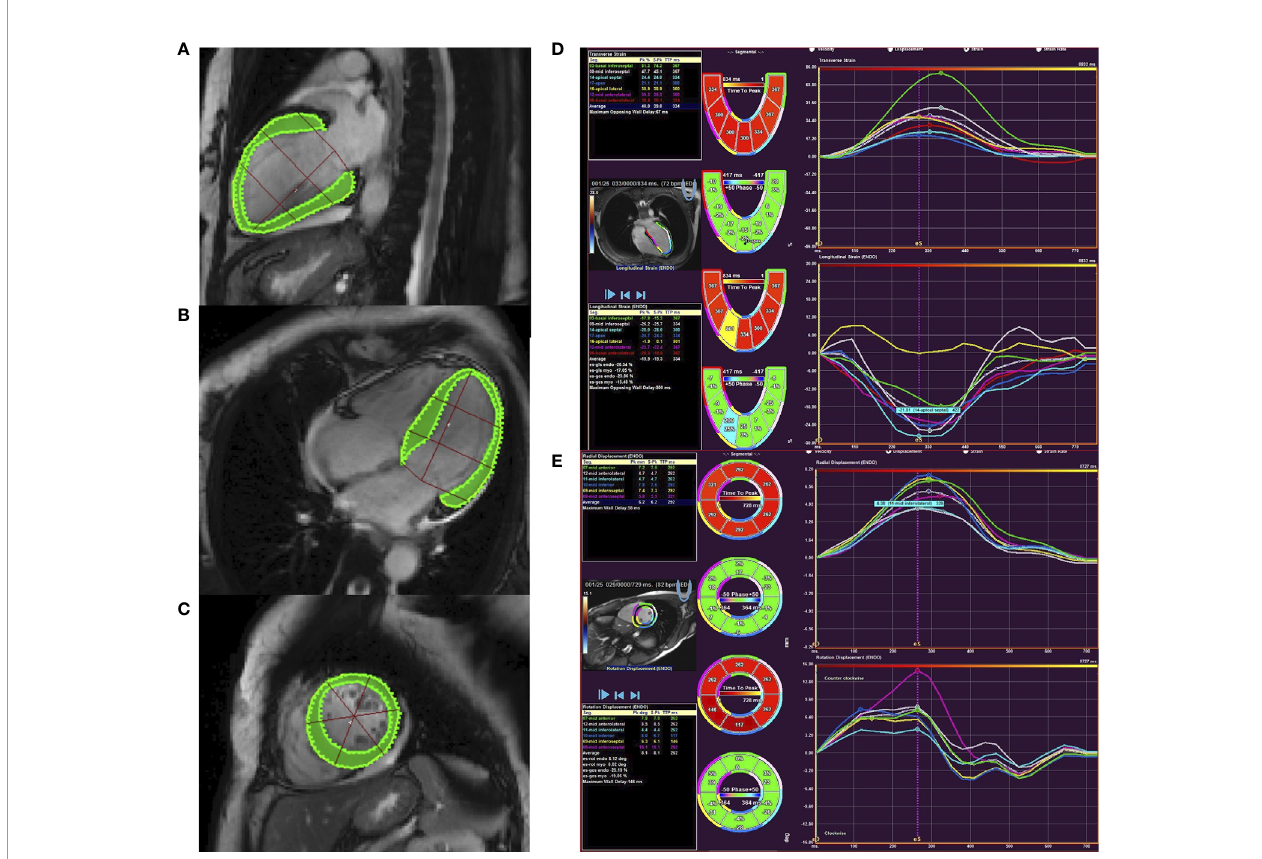
FIGURE 2 | Cardiac magnetic resonance feature tracking of the left ventricle in PA patient. Panels (A – C) showed countering for LV longitudinal (A) , circumferential (B) , and radial (C) strain and strain rate. Panel (D) showed tracking in the short-axis image with circumferential and radial strain curves. Panel (E) showed tracking from the four-chamber image to derive longitudinal